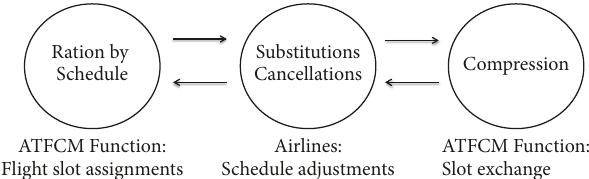
Figure 4: Classical CDM